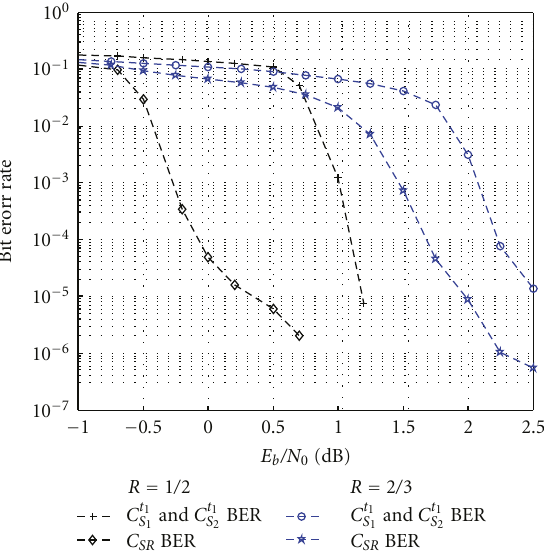
Figure 10: The BER performance under the AWGN channel with BPSK, d = 0.5.